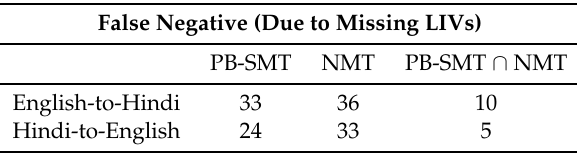
Table 11. False negatives in the PB-SMT and NMT tasks when TermEval fails to capture term translations as correct due to the absence of an appropriate LIV in gold-test